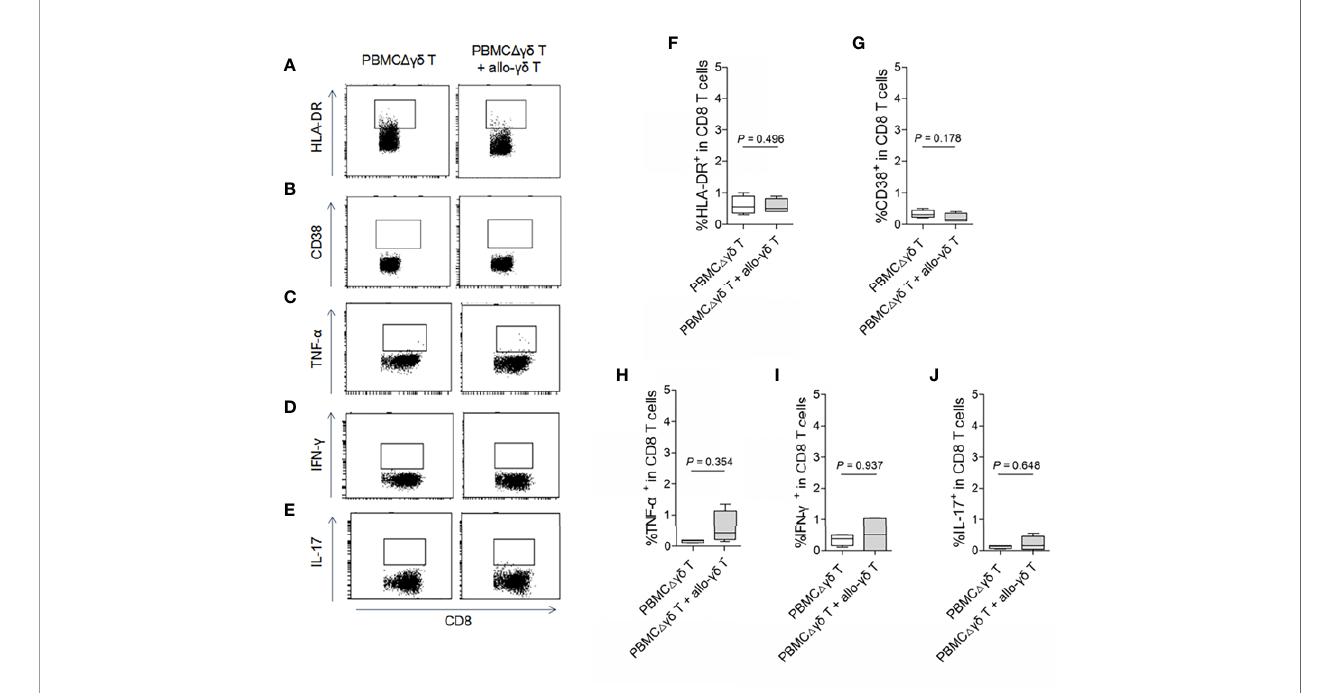
FIGURE 3 | Assay for the reactivity of CD8 T cells in response to stimulation of allogeneic gd T cells. MLRs were performed by co-culture of puri fi ed allogenic gd T cells with PBMC Dgd T cells isolated from healthy donors, at a ratio of 1:3. Cells were collected on day 5 after co-culture and stained with antibodies against CD8 (A – J) , HLA-DR (A, F) , CD38 (B, G) , TNF- a (C, H) , IFN- g (D, I) and IL-17 (E, J) . Data are expressed as the mean ± SD of triplicate cultures. P values are shown on the